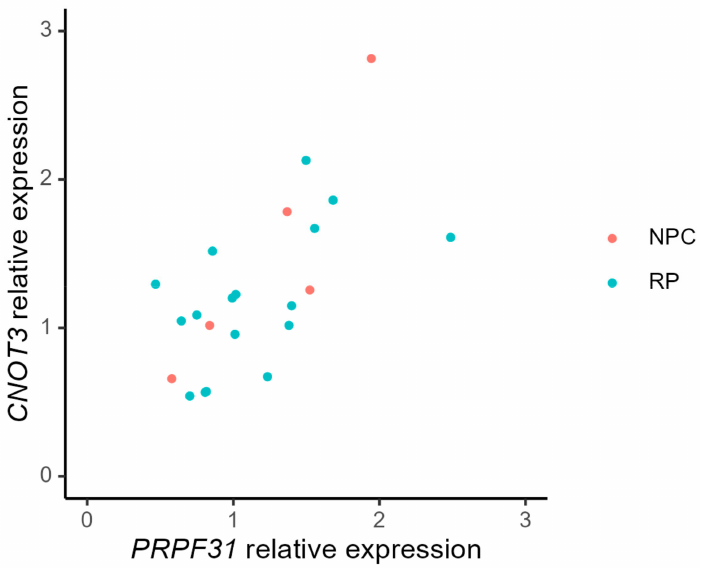
Figure 4. mRNA expression levels in peripheral blood of CNOT3 and PRPF31 . The non-penetrant carriers (NPC) are depicted as red dots and individuals with RP as blue dots.